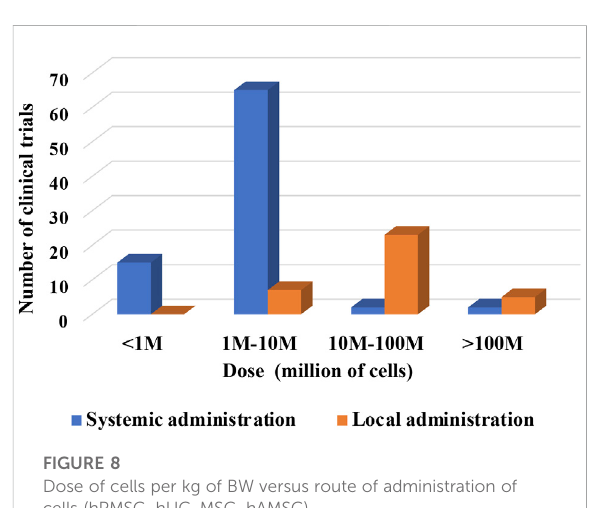
FIGURE 8 Dose of cells per kg of BW versus route of administration of cells (hPMSC, hUC-MSC,